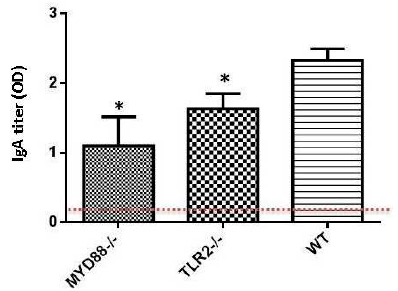
Figure 2. TLR signaling might mediate the generation of CTB-specific fecal IgA antibody production.